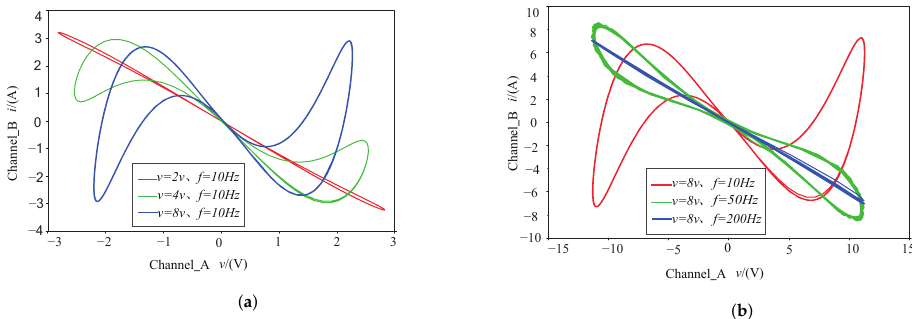
i plane. i plane. − −